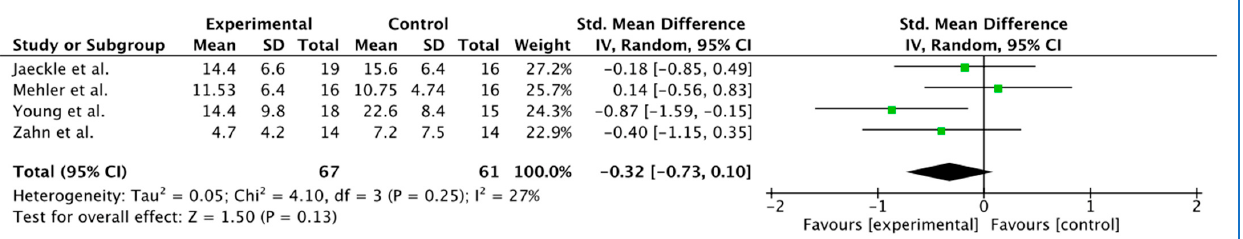
Figure 4. Forest plot. Reduction in depression severity clinical scores from baseline to the end of treatment. The figure displays for each study included in the meta-analysis the summary statistics (mean, standard deviation, and sample size) of depression severity clinical scores for the experimental and control groups, and its standard mean difference and its 95% confidence interval.